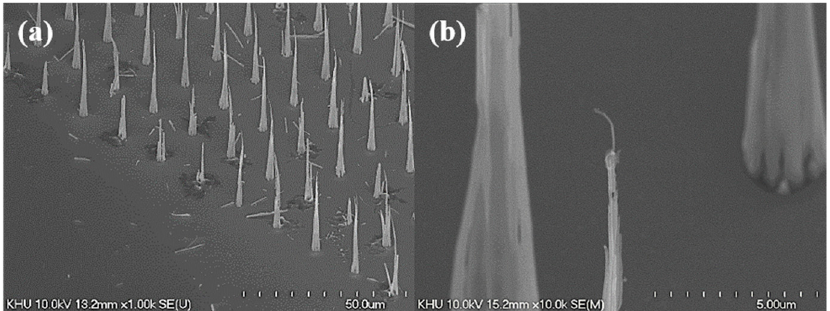
Figure 5. ( a ) Damaged CNT emitters by excessive Joule heating; ( b ) tip of a structurally modified